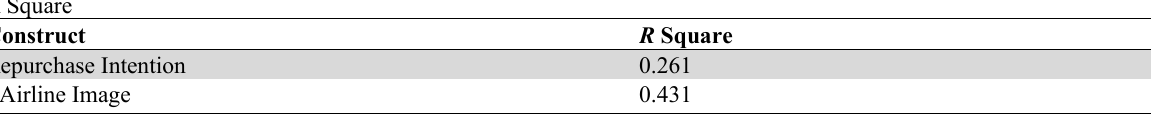
F Square AI RPI AI 0.091 AI×PPF 0.016 GUST 0.176 0.035 PPF 0.098 TCH 0.108